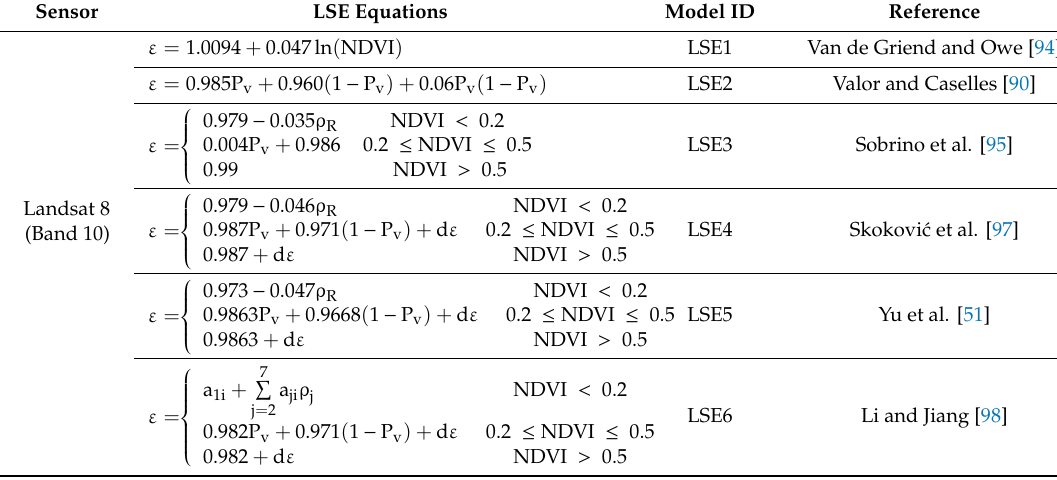
Table 3. The expressions of Normalized Di ff erence Vegetation Index (NDVI)-based Land Surface Emissivity (LSE) models considered in this